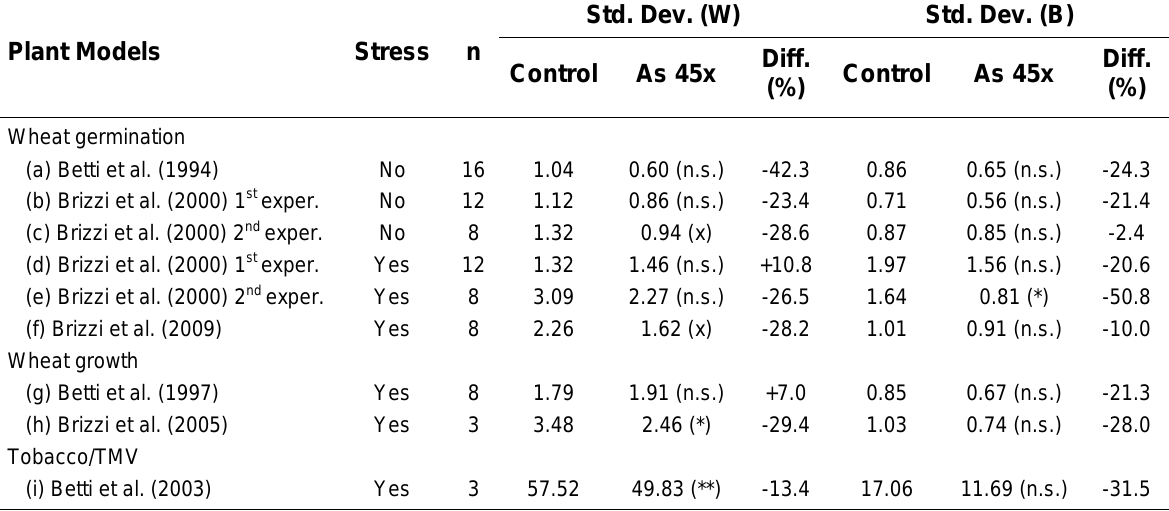
Standard Deviation Components Observed in Different Plant Models (W = Within Experiments, B = Between Experiments)